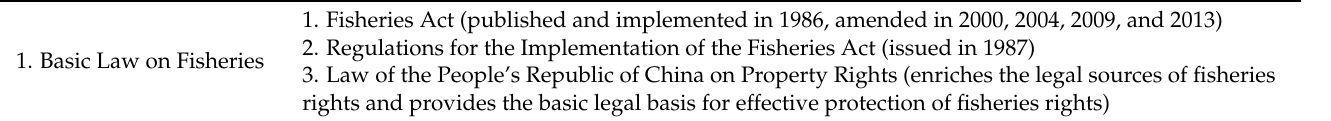
Table 1. Fishery laws and regulations classification by